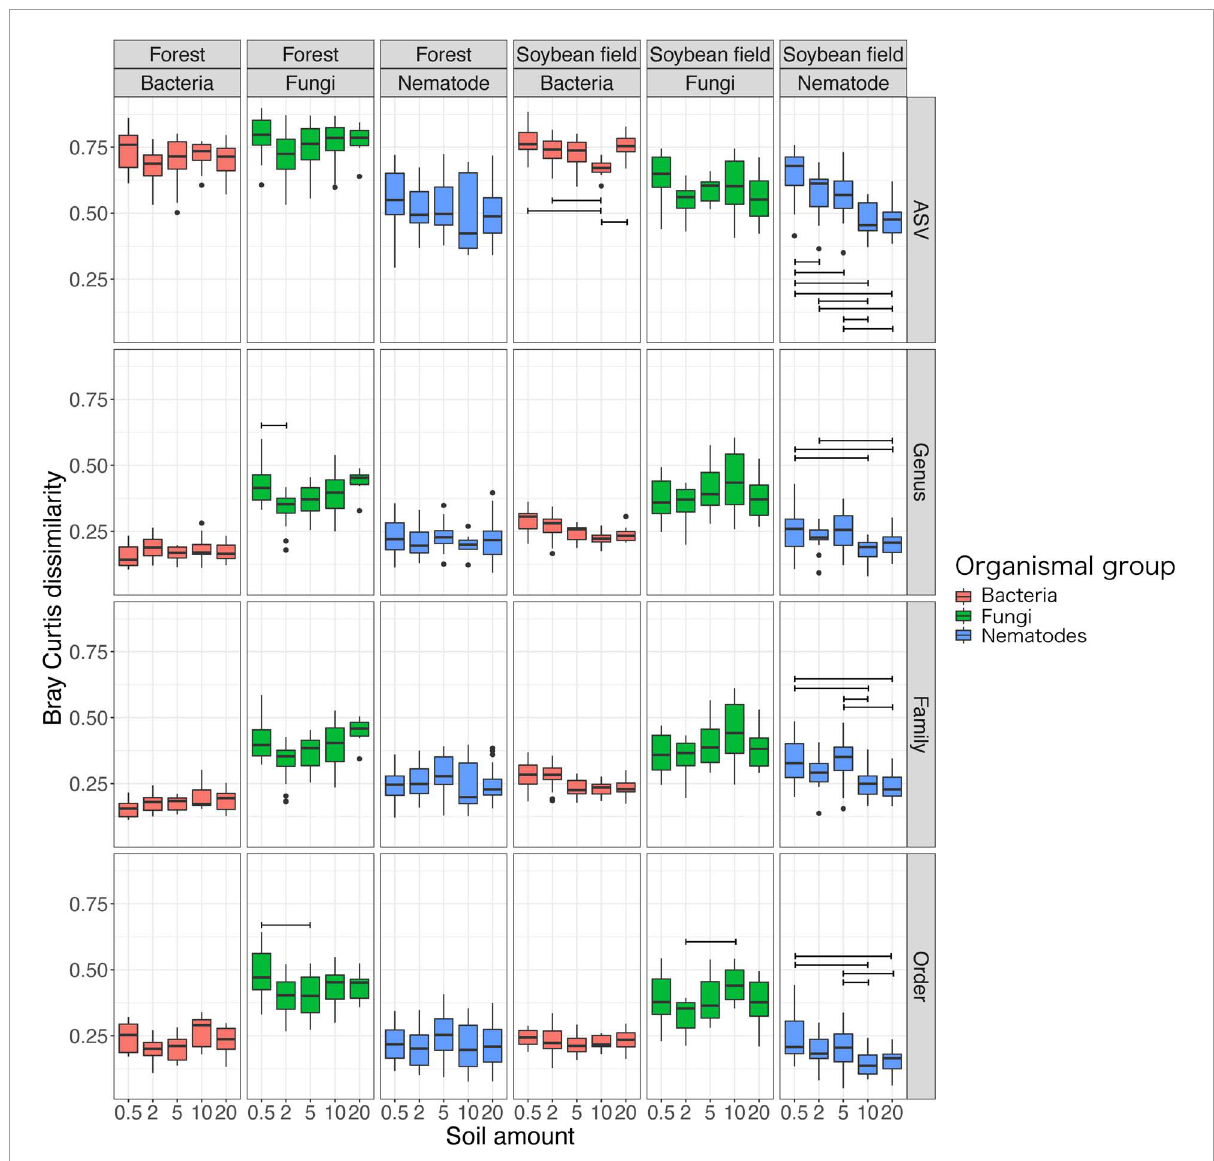
FIGURE5 Dissimilarity of community compositions among replicate samples. For each organismal group (bacteria, fungi, and nematodes) in each ecosystem type (forest or soybean field), Bray-Curtis dissimilarity ( β -diversity) among replicate samples are shown at each of the ASV, genus, family, and order levels. An ANOVA analysis testing potential effects of soil amount in DNA extraction on β -diversity estimates was performed for each panel. See Table 2 and Supplementary Table 2 for the results of the ANOVAs in which we included soil amount, ecosystem type (forest or soybean field), and the interaction of the two